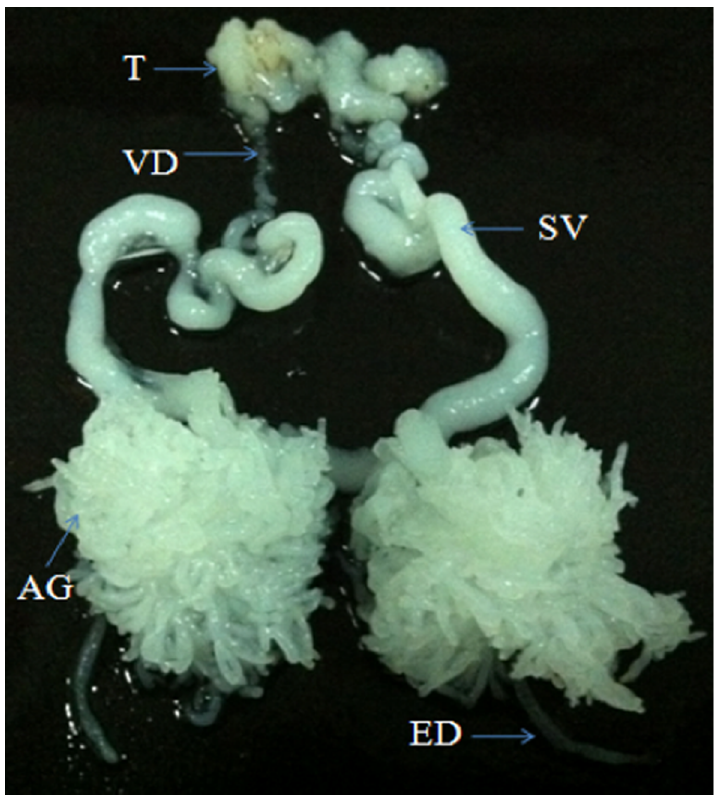
Fig 1. Photograph of the male reproductive system in the E . sinensis . The male reproductive system of this crab consists of a pair of testes (T), vas deferens (VD), seminal vesicles (SV), accessory glands (AG) and ejaculatory duct